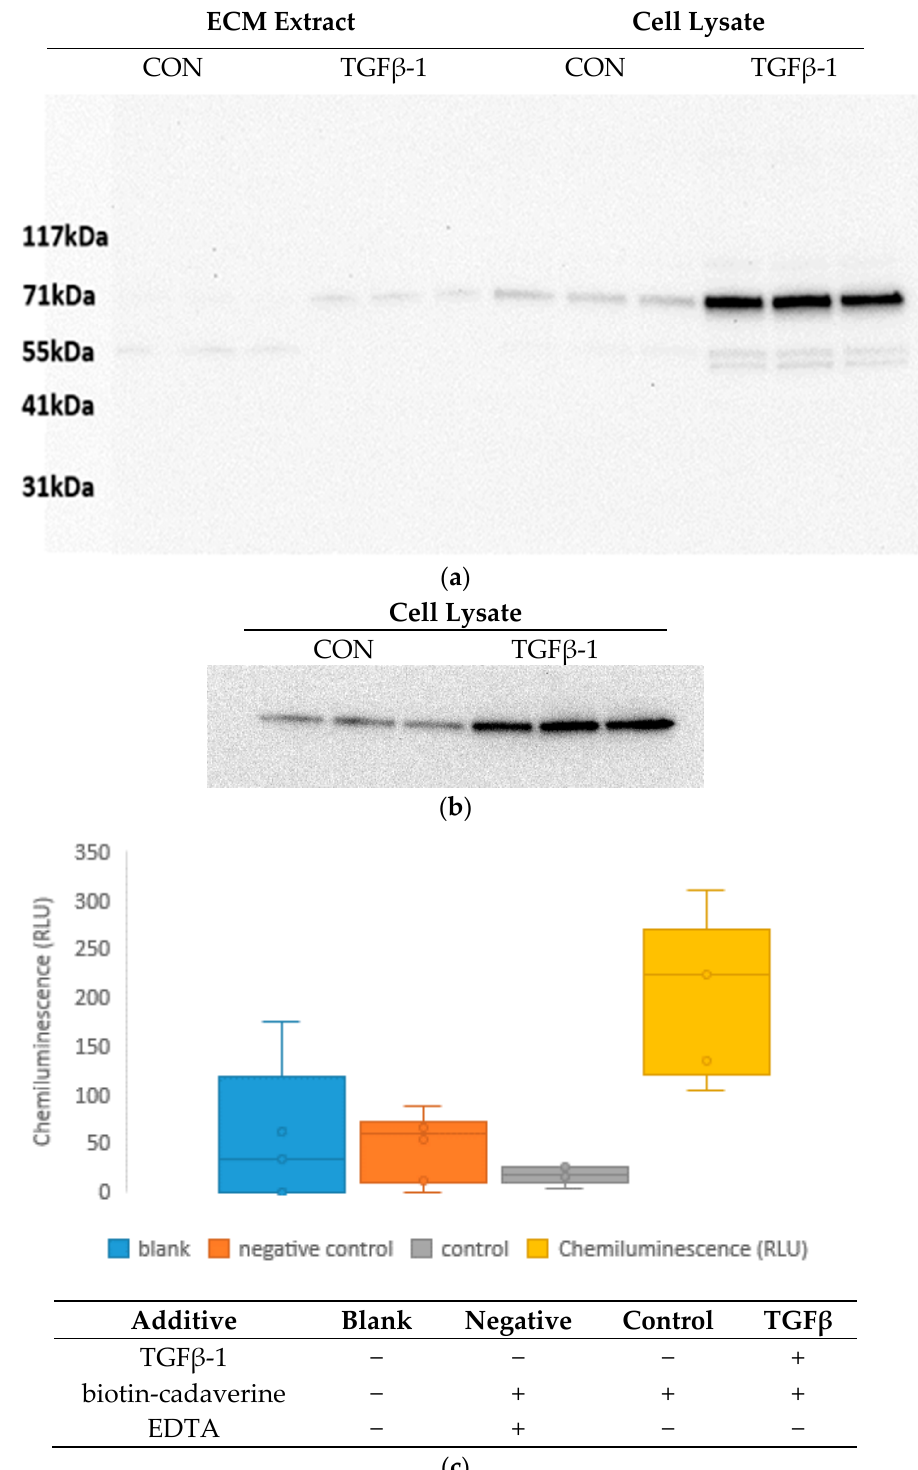
Figure 3. TG2 activity and Western blot analysis of decellularised control and TGF β -1-treated cell cultures. ECM and cell lysates prepared from control and TGF β -1-treated cultures after 15 days of incubation ( n = 3) were immunoblotted with antibodies to TG2 (expected molecular weight 77 kDa) ( a ) and GAPDH ( b ). Panel ( c ) depicts the datasets (excluding outliers) in a box and whisker plot. Activity assay data are presented in relative luminescent units (RLU) alongside with information about the medium composition in each condition. The presence and absence of the additives are marked with + and—, respectively.